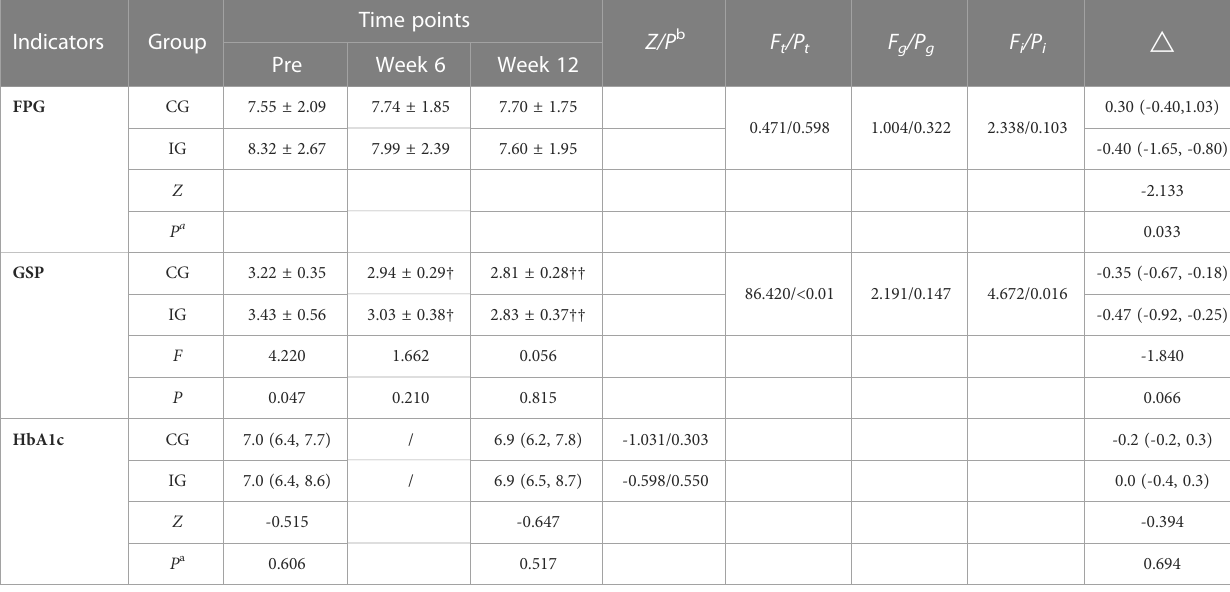
TABLE 3 Changes in blood glucose indicators in the two groups, (mean ± SD) or M (P 25 , P 75 ) .